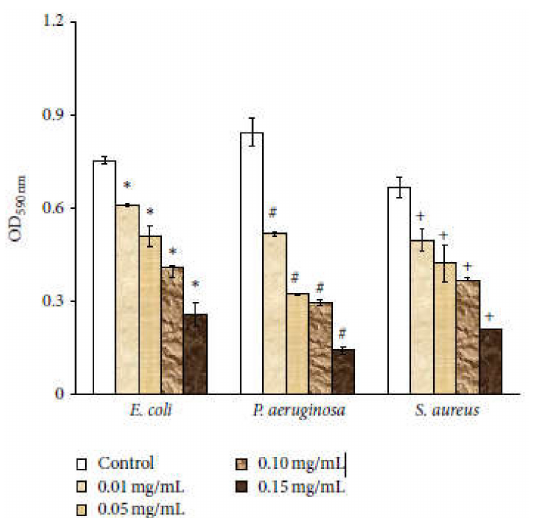
Figure 3. Optical density measurements of 24 h biofilm growth on pluronic coated TCPS surface in the presence of different concentrations (0.01 mg/mL, 0.05 mg/mL, 0.10 mg/mL, and 0.15